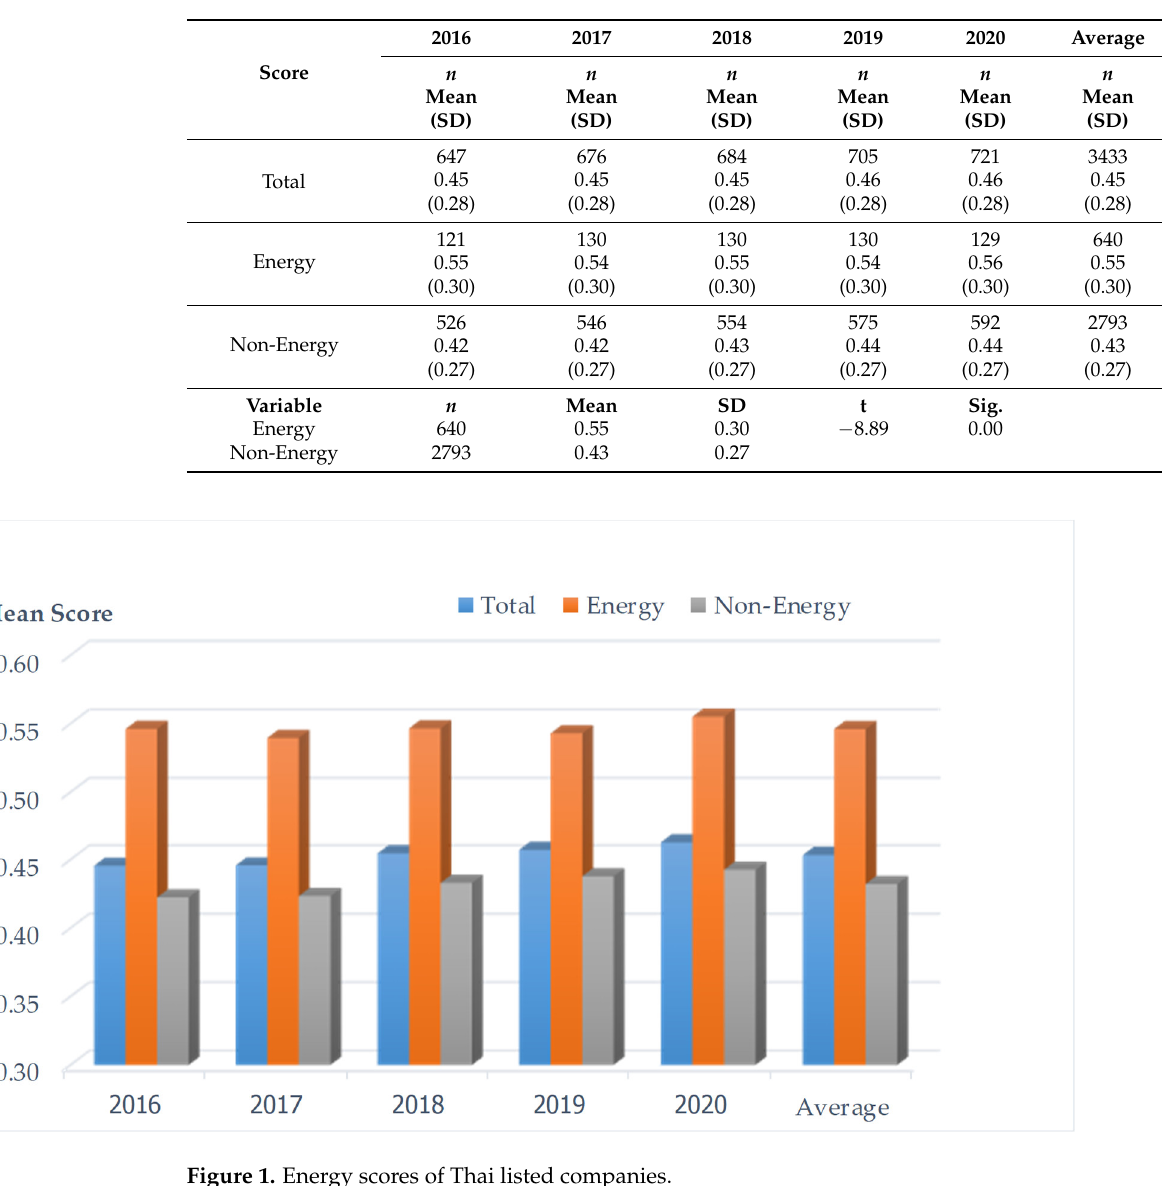
Table 3. Descriptive analysis of energy score and t -test for differences in energy and non-energy- intensive industries.